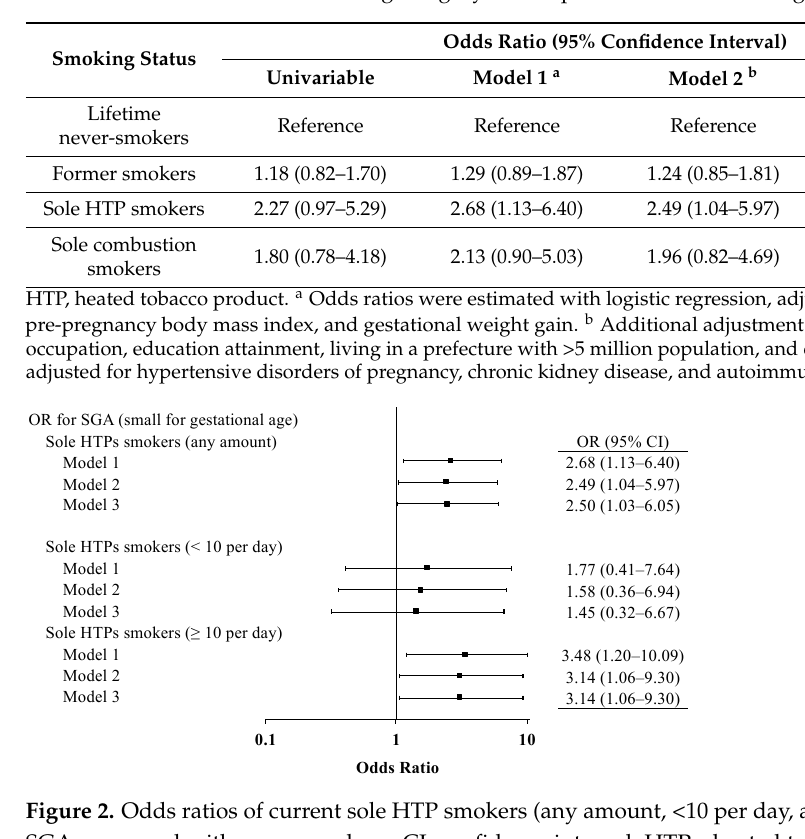
Table 2. Odds ratios of each smoking category for the prevalence of small for gestational age.